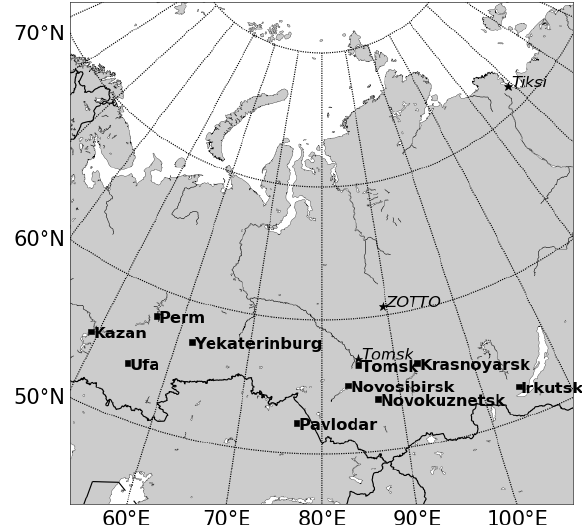
Figure 1. Map of the domain used for model simulations. Centred on the western Siberia region, with major cities (squares) (popula- tion > 100000) shown in bold. Observation sites (star symbols) are given in